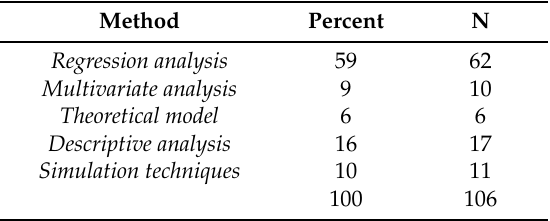
Table 4. Methodological approach in micro-level land-use change studies.